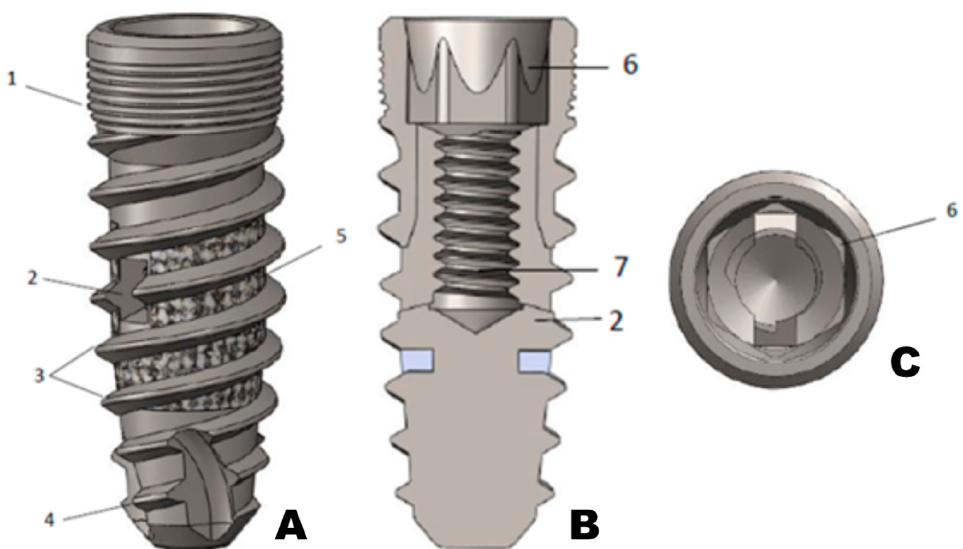
Figure 1. Dental implant body. ( A ) outside screw appearance, ( B ) coronal section, and ( C ) top view.